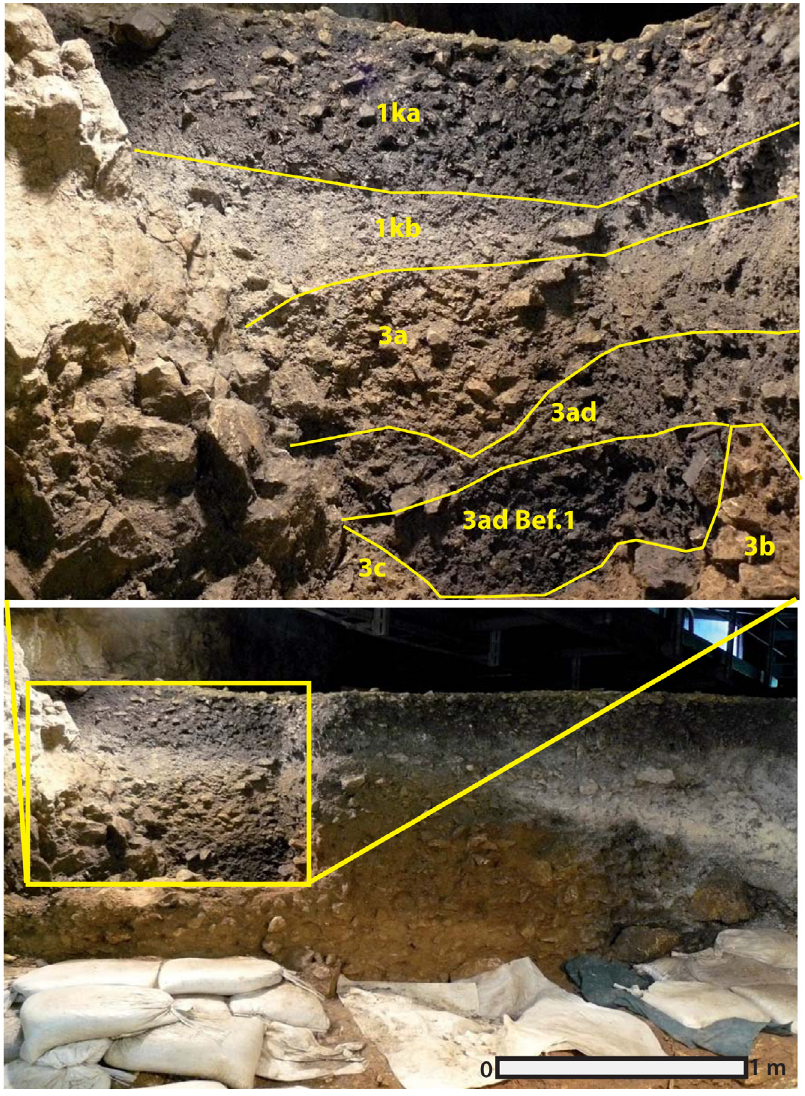
Figure 2. Hohle Fels Cave, stratigraphy, Magdalenian geological horizons. After Conard and Malina